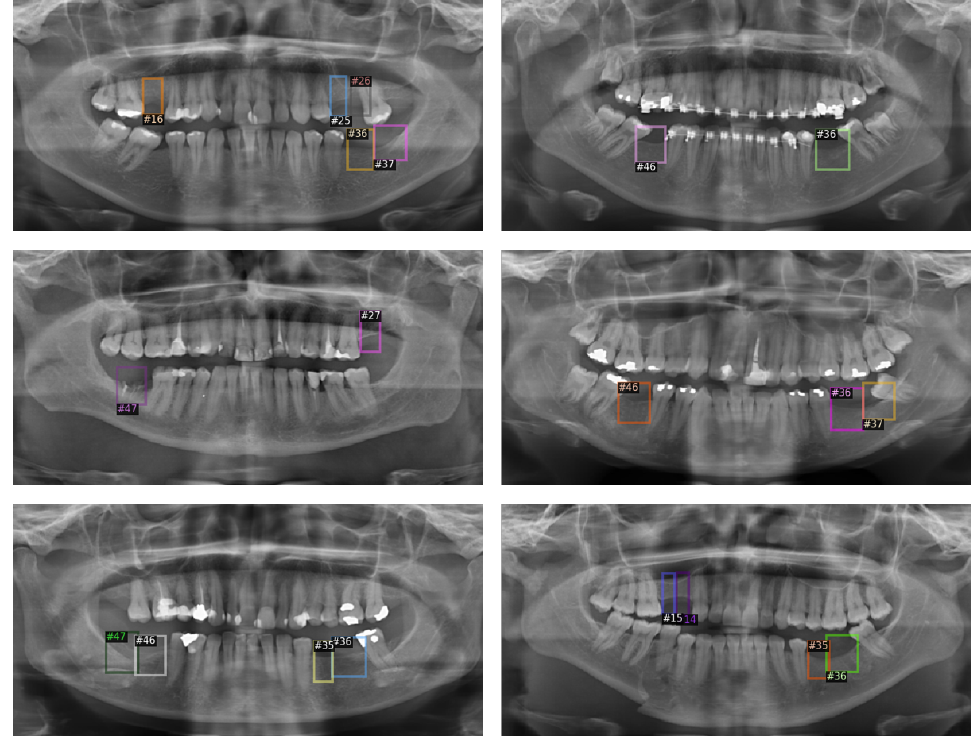
Figure 6. Visualization of missing tooth regions detection model